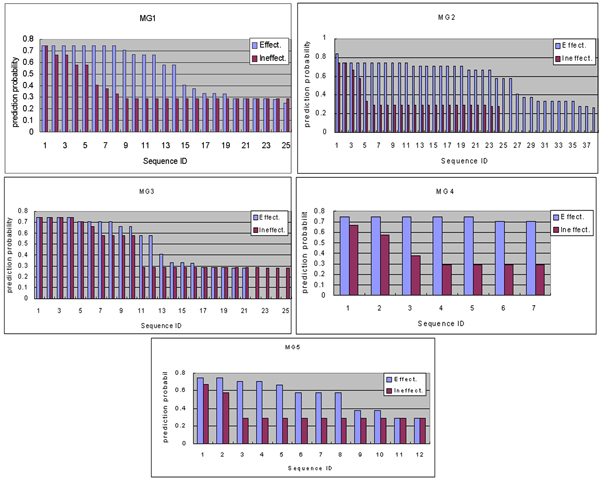
Prediction probability distributions of siRNA sequences effective and ineffective for MG1 to MG5 by the proposed decision tree method. The probabilities for effective ("Effect") and ineffective ("Ineffect") siRNAs computed by using the proposed decision tree method are shown for (a) MG1, (b) MG2, (c) MG3, (d) MG4 and (e) MG5.